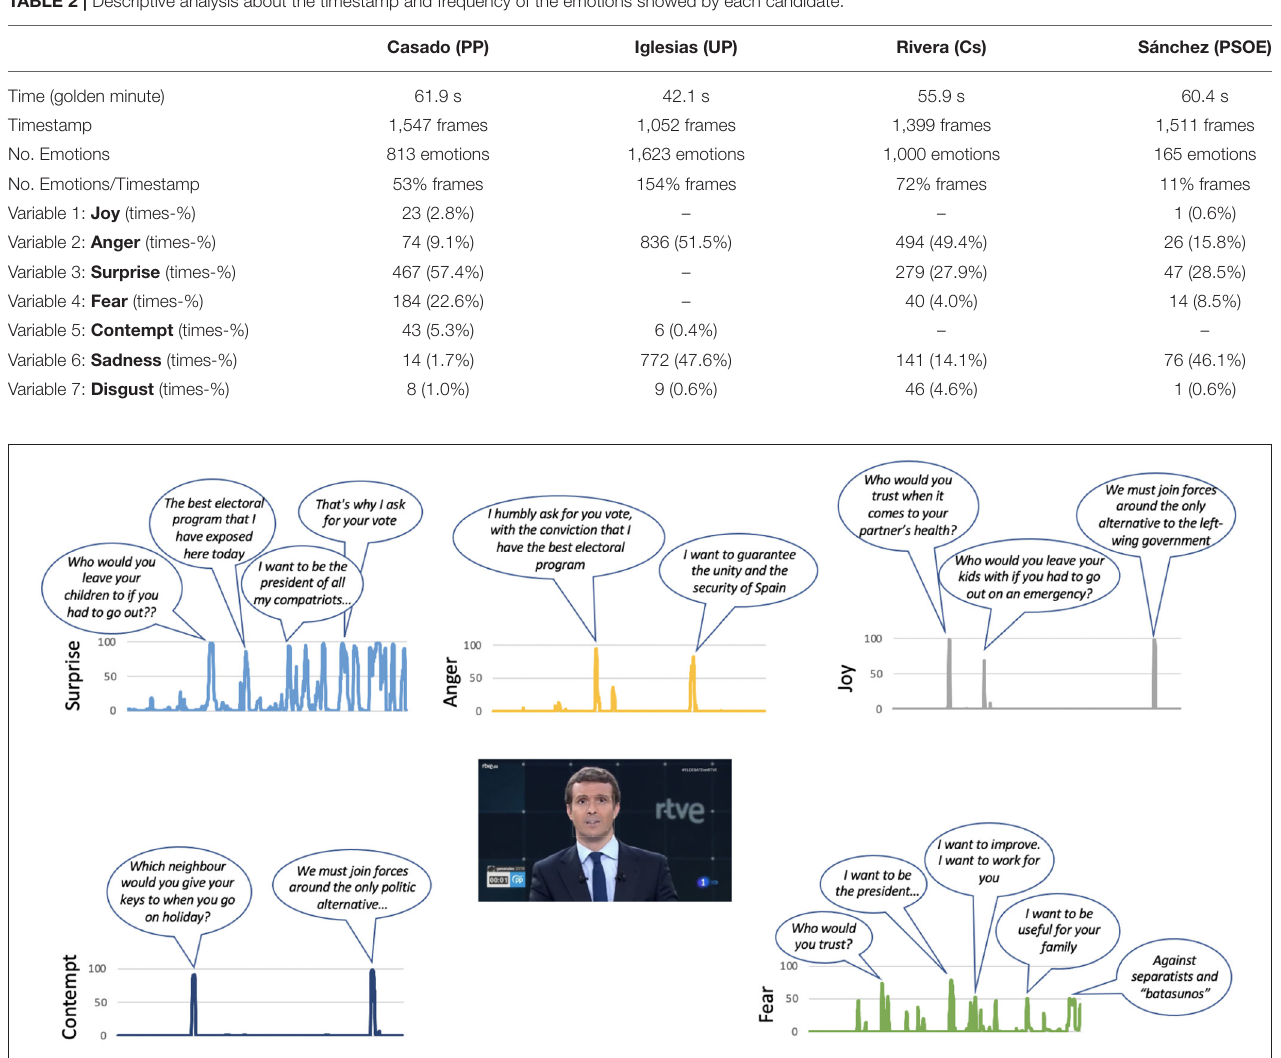
FIGURE 5 | The main phrases of Pablo Casado’s speech during the golden minute associated with certain